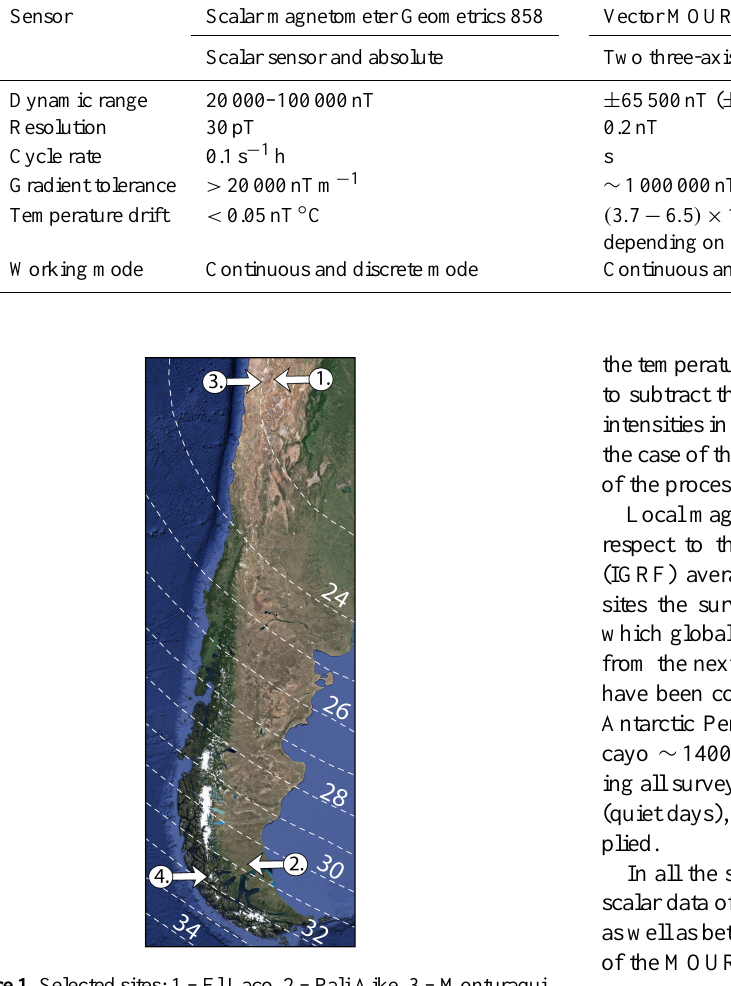
Figure 1. Selected sites: 1 – El Laco, 2 – Pali Aike, 3 – Monturaqui, and 4 – Bahía Glaciers located in South America between latitudes 20 and 52 ◦ S. The white stippled lines indicates isolines for intensi- ties (in nT × 10 3 ) of the International Geomagnetic Reference field ranging from 23000 to 32000nT at the different